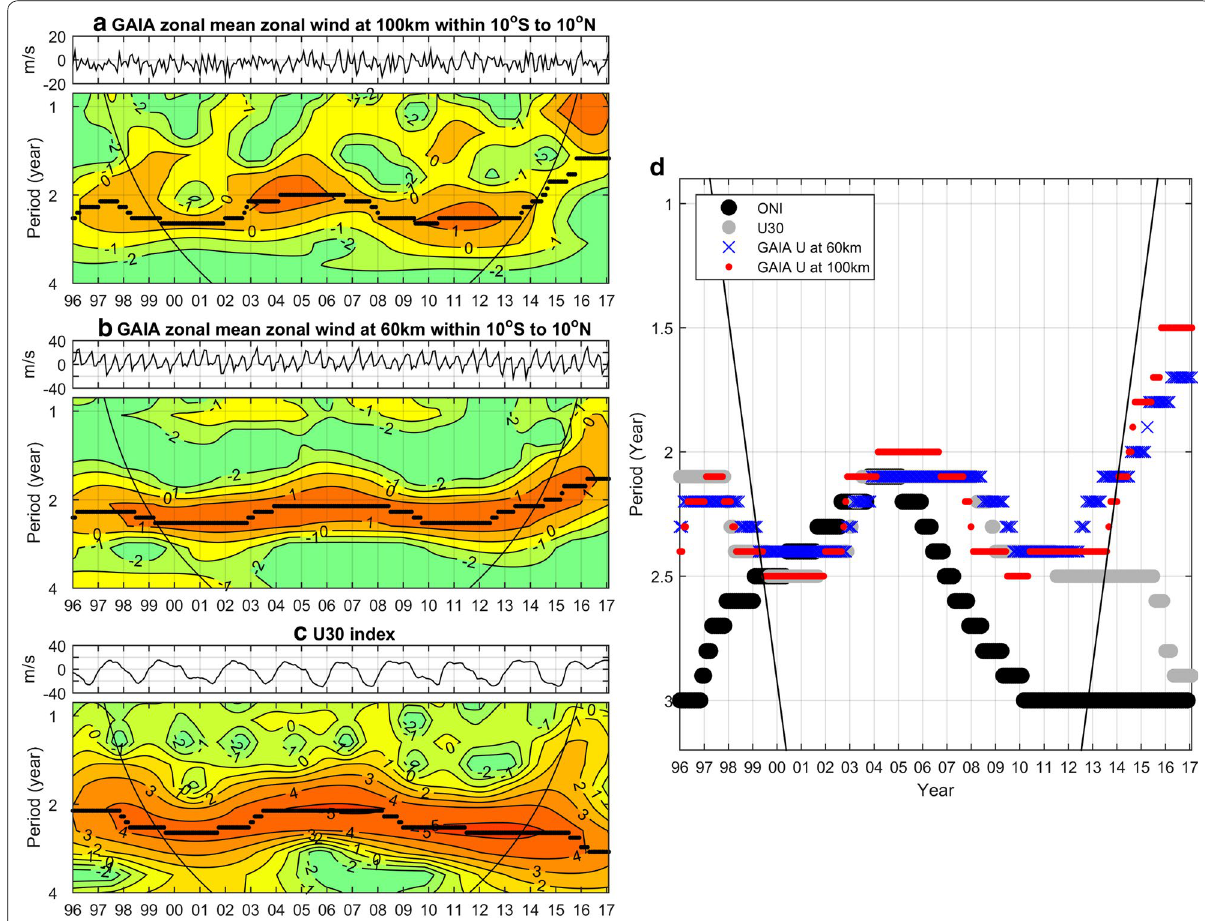
Fig. 4 Wavelet power spectra of the GAIA zonal mean zonal wind averaged within 10°S to 10°N at a 100 km and b 60 km altitudes. c Spectrum of the U30 index. The U30 index is the zonally averaged winds at 30 mb over the equator from the CDAS Reanalysis data. It represents the strato‑ spheric QBO at 30 mb altitude. d Periods of the U30 index and QBOs in the GAIA zonal mean zonal wind at altitudes of 60 and 100